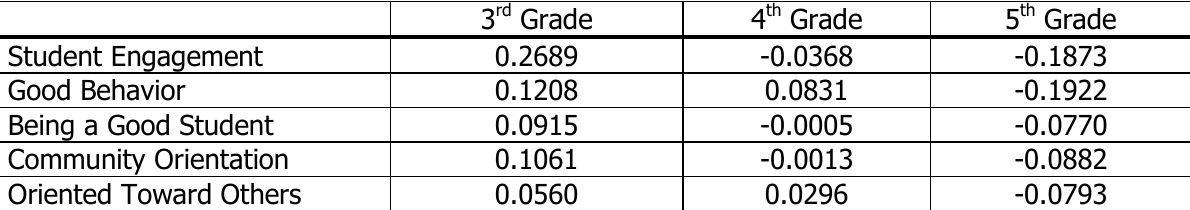
Comparing Levels of Student Outcomes in Spring, by Grade